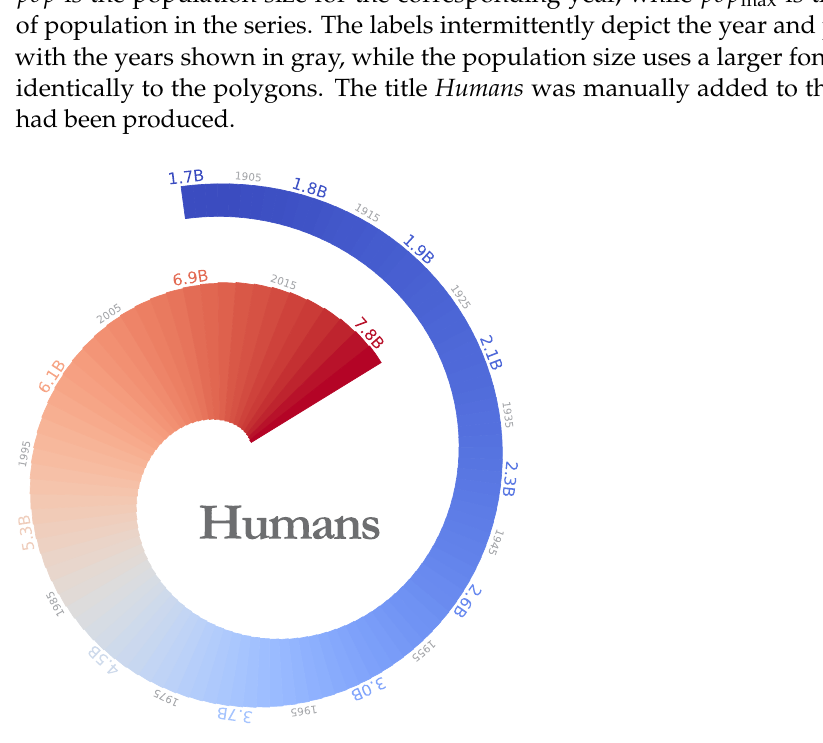
Figure 3. Increase in world population in the period of 1900–2021. The colors depend on the population size, with the width being proportional to population size. The labels intermittently depict the year and population size, with the years shown in gray, while the population size is colored identically to the polygons. The population size is expressed in billions (e.g., 1.7 B represents 1.7